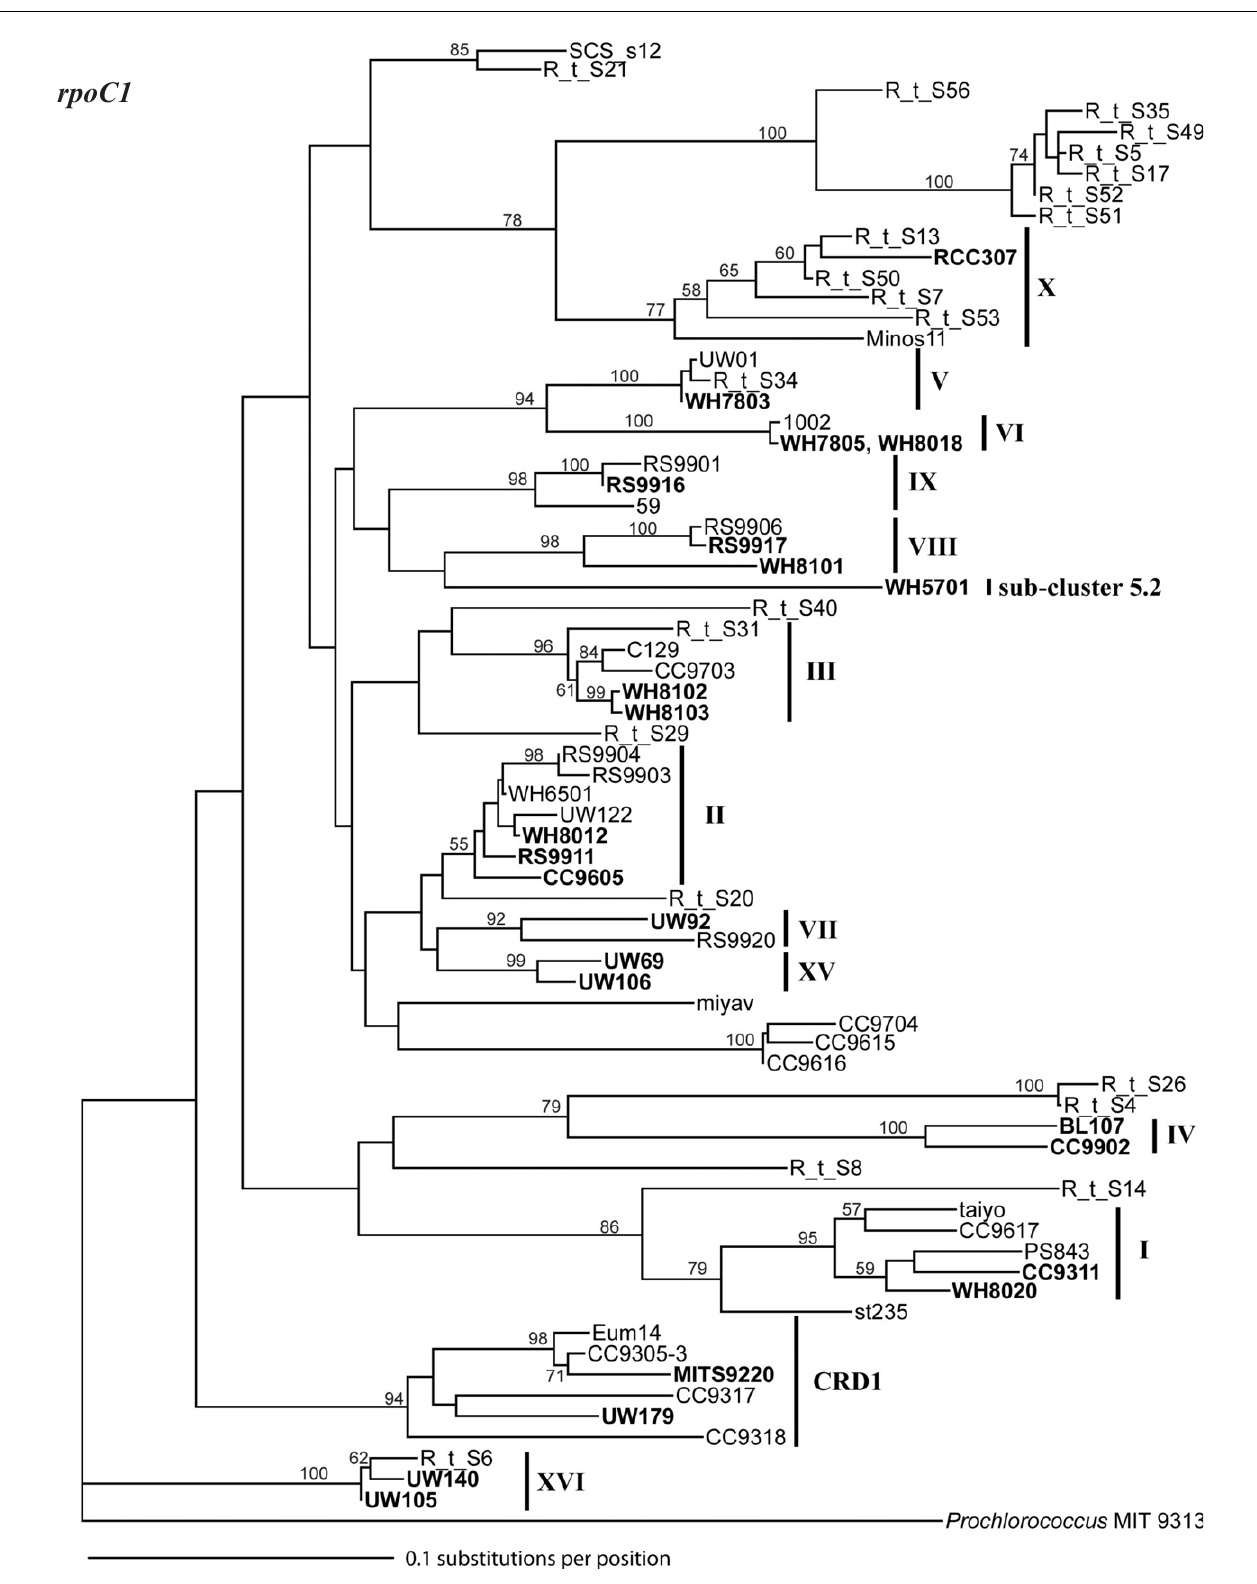
FIGUREA5 | Phylogenetic tree based on 460 nucleotide positions of the rpoC1 gene. Tree construction, bootstrap analysis, and taxa and clade labels are the same as described in FigureA1 . Prochlorococcus strain MIT 9313 was used as the outgroup.